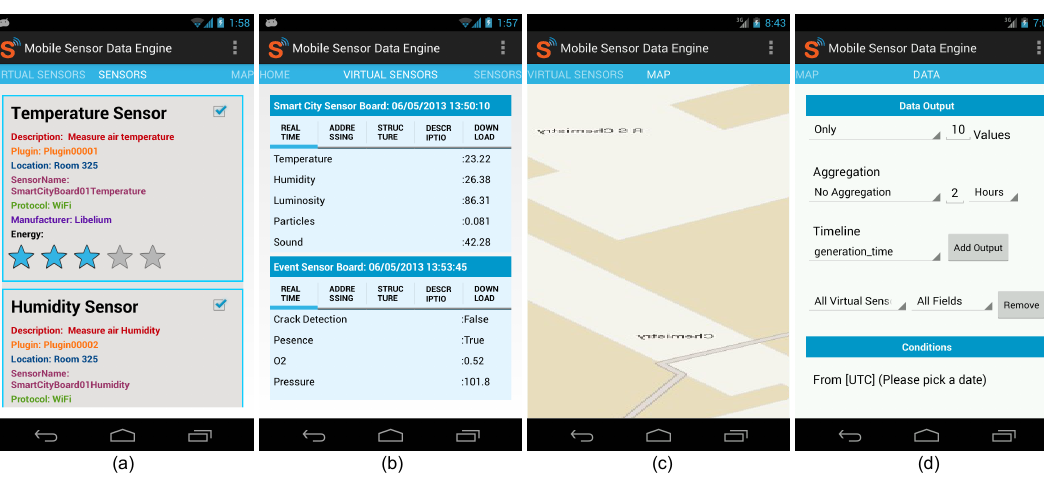
Figure 5. MOSDEN screenshots: (a) List of sensors connected the MOSDEN; (b) List of virtual sensors currently running on the MOSDEN and their details; (c) Map that shows sensor locations; and (d) Interface for data fusing and filtering Table 1. LOC to develop a Noise Pollution